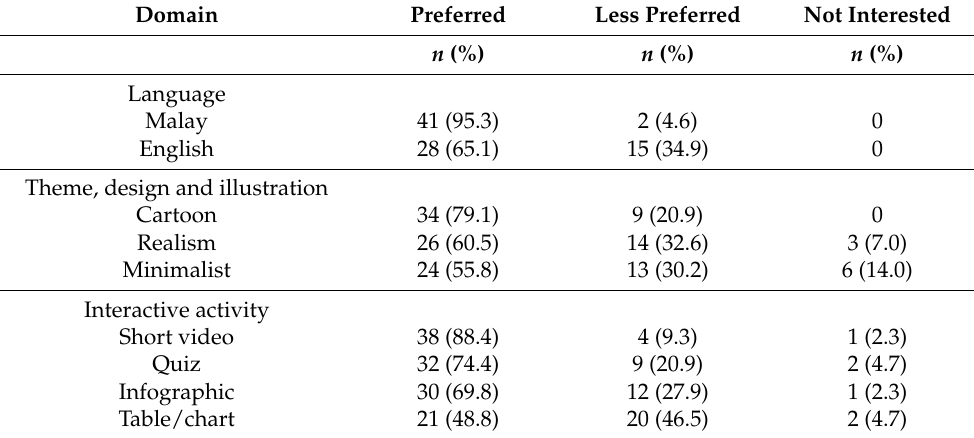
Table 3. Preferred characteristics of health education materials among adolescents in needs assessment ( n =